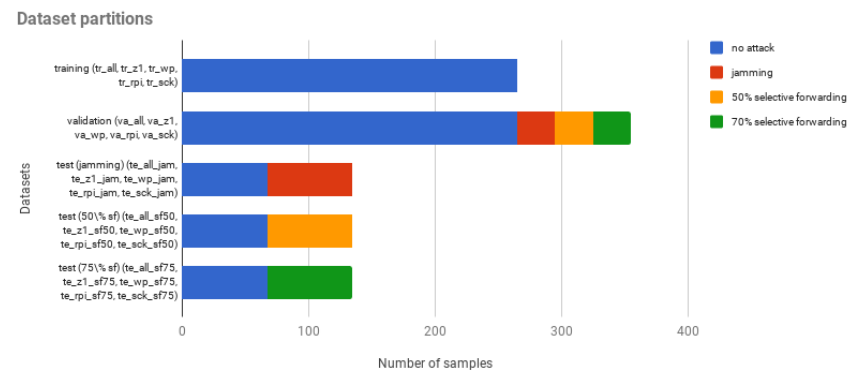
Figure 8. Dataset